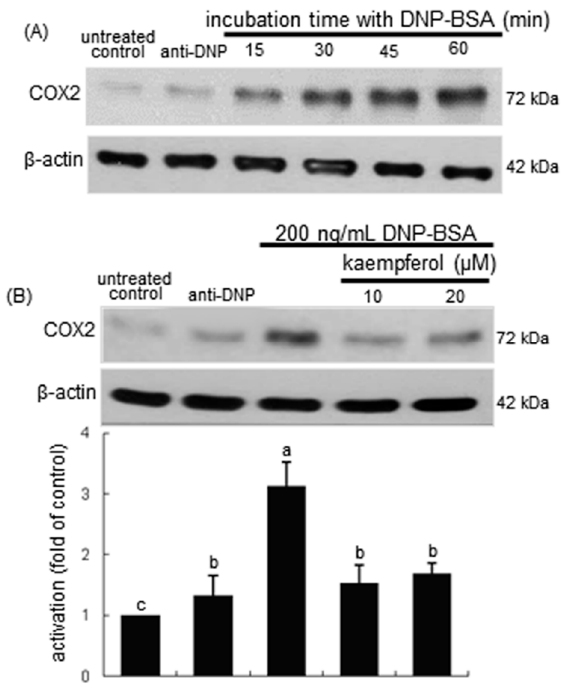
Figure 2. Temporal response of cyclooxygenase 2 (COX2) induction ( A ) and inhibitory effect of kaempferol on COX2 induction ( B ) in sensitized RBL-2H3 cells. Rat basophilic leukemia RBL-2H3 cells were sensitized by the addition of 0.5 µ g/mL anti-2,4-dinitrophenol (anti-DNP) and stimulated for 5–60 min with 200 ng/mL DNP-bovine serum albumin (BSA) in the absence and presence of 10–20 µ M kaempferol. Equal amounts of cell lysate proteins were subject to 8% SDS-PAGE and Western blot analysis with a primary antibody against COX2. The blot data (mean ± SEM, n = 3) in the bar graphs represent quantitative results obtained from a densitometer. Values in bar graphs not sharing a common letter refer to significantly different at p < 0.05.